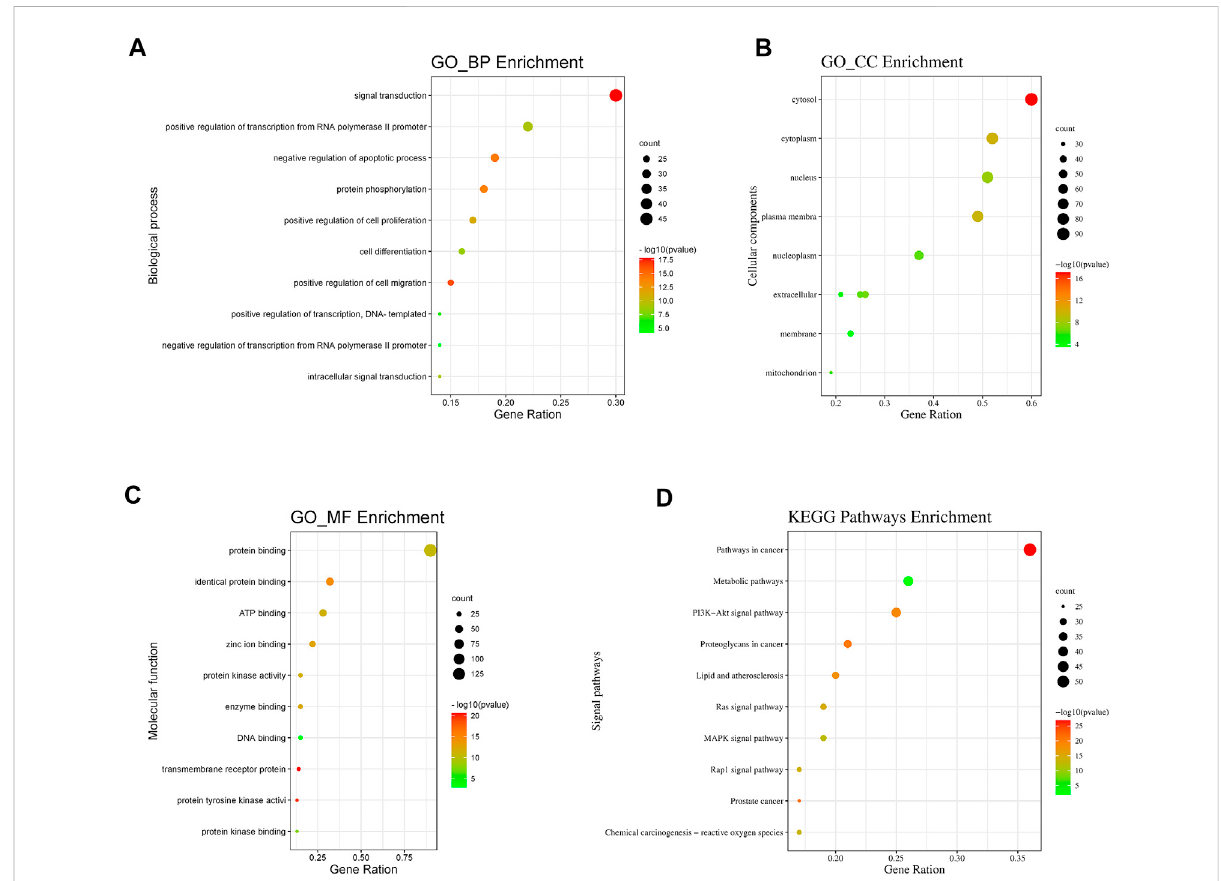
FIGURE 3 GO and KEGG pathway analysis of intersecting genes (A,B,C) Bubble plot for top 10 biological processes, cellular components and molecular functions of the GO enrichment analysis (D) Bubble plot for top 10 signaling pathways of the KEGG pathway enrichment